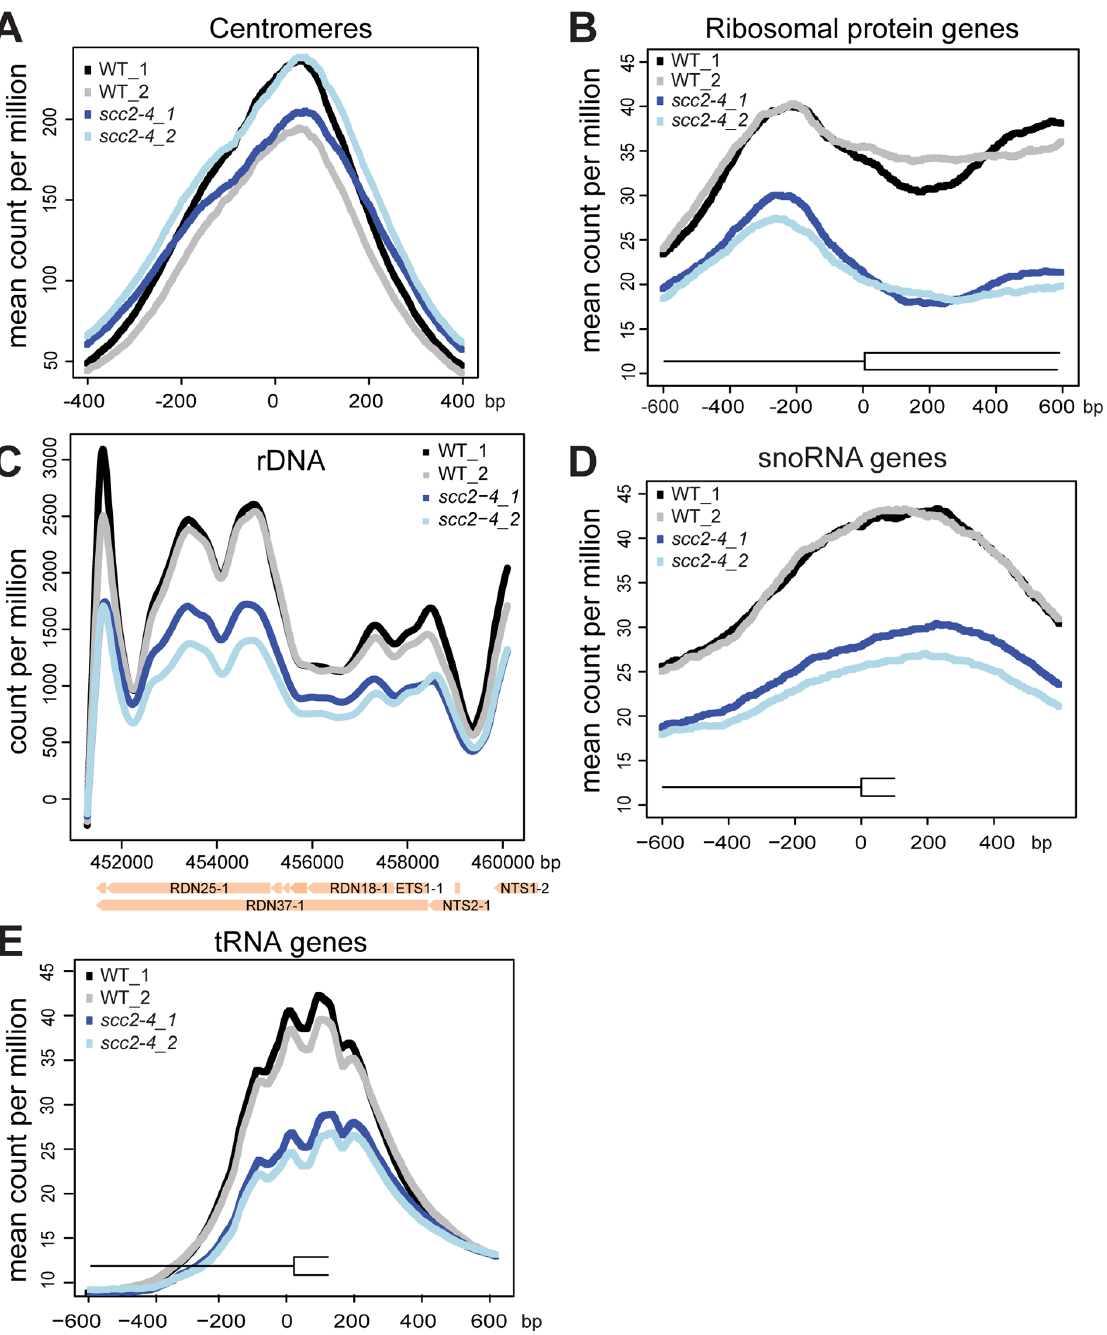
Fig 2. The scc2-4 mutation compromises the association with genic regions at 30°C. WT and scc2-4 mutant strains were cultured to mid-log phase (~OD 600 = 0.5 – 0.8) in YPD medium. Strains were crosslinked and chromatin extracted for ChIP. Metagene analysis was carried out for Scc2-Myc and Scc2 E534K -Myc for ChIP seq data. Two biological replicates for each are shown. (A) The scc2-4 mutation does not affect the association of Scc2 with centromere regions. (B) The mutation reduces the association with ribosomal protein genes (132) (C) rDNA (D) snoDNAs (77) and (E) tDNAs (275).